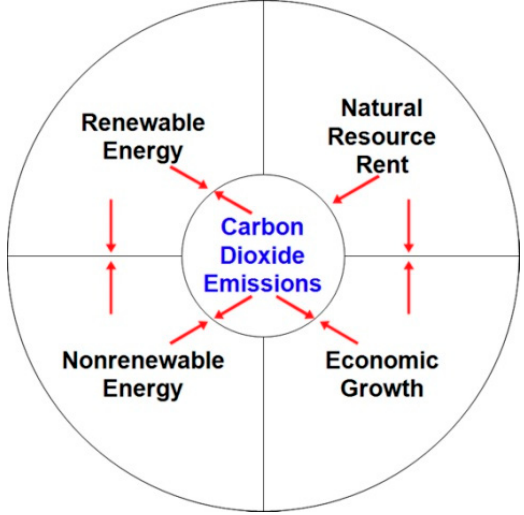
Figure 1. Factors influencing carbon dioxide emissions [29].